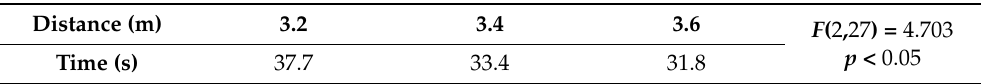
Table 8. Time data after division of the overall situational awareness information depths and distance ranges.